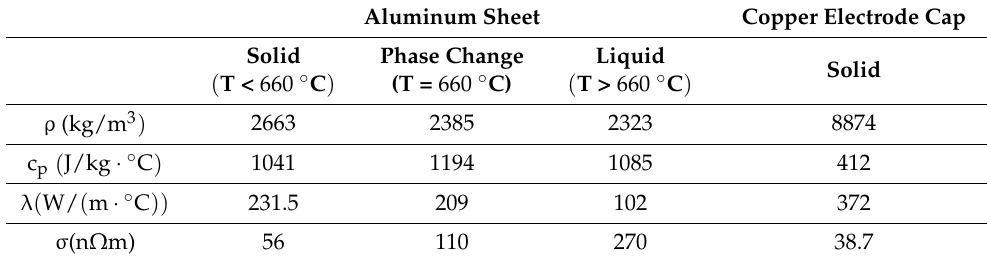
Table 2. Material data